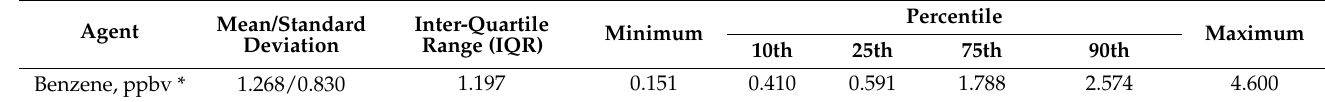
Table 2. Outdoor benzene distribution